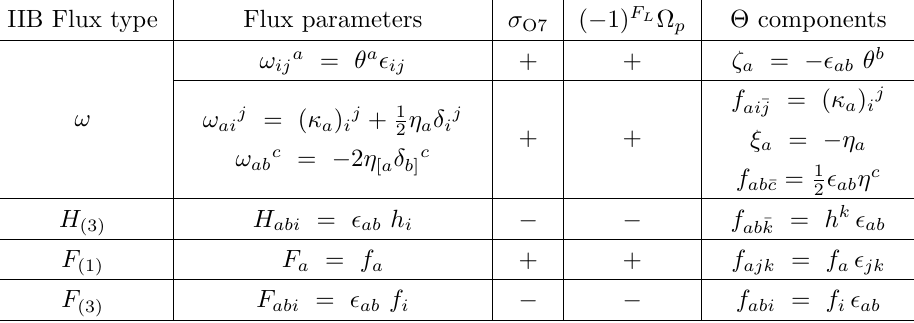
Table 18 . The explicit dictionary between type IIB (cid:13)uxes consistent with the O7 involution and deformation parameters of N = (1 ; 1) supergravity in six dimensions. Raising SL(2 ; R ) indices has been done via h i = (cid:15) ij h k and (cid:17) a = (cid:15) ab (cid:17) b